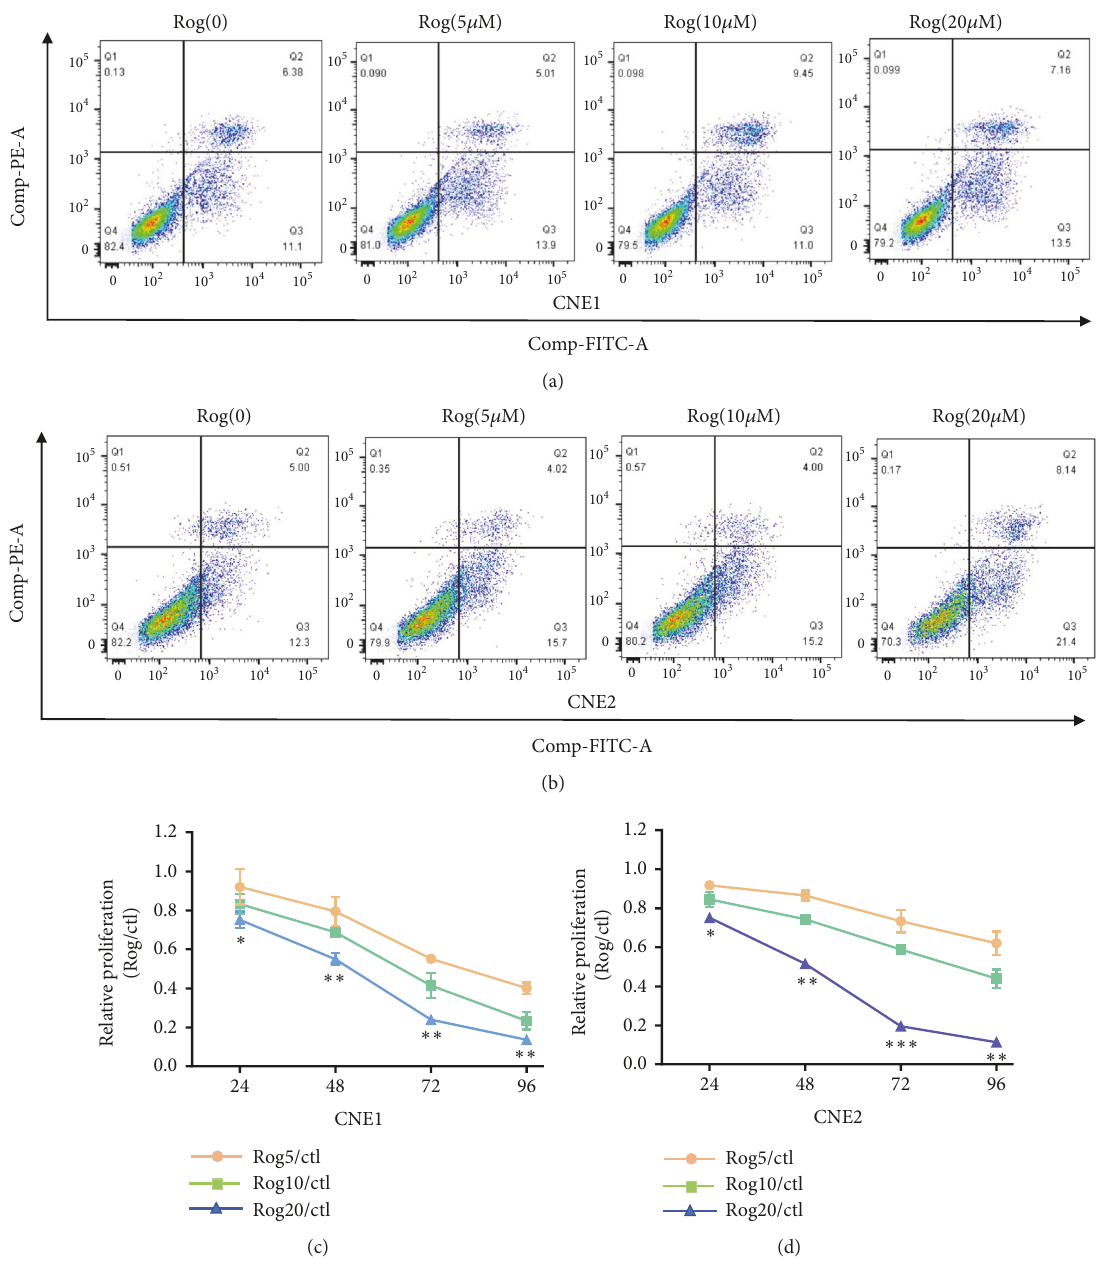
Figure 3: PPAR- 𝛾 ligand inhibits the proliferation of CNE1 and CNE2 cell lines . (a, b) rh Annexin V-FITC assay was performed to detect the percentage of apoptotic cells relative to the total number of cells in CNE1 and CNE2 cell lines after treatment with dose-dependent Rog. (c, d) Analysis of a CCK-8 proliferation assay of CNE1 and CNE2 cell lines.